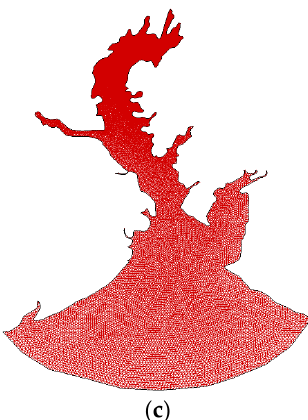
Figure 1. ( a ) Location of Tieshangang Bay; ( b ) Topographic map of Tieshangang Bay; and ( c ) the unstructured grid for the MIKE 21 FM and a close-up of the variable mesh resolution. The performance of MIKE 21 FM was validated against (1) the tide level records at Shatian and Shitoubu, which is obtained from the local tide gauge stations; and (2) the magnitude and direction of velocity records at three temporary measurement points in Tieshangang Bay (Figure 1b). The velocities were obtained from the previous study on this area [15], which were measured in 1-m cell size and 1 Hz data rate with a sampling time of 30 min using Aquadopp Profiler (Nortek Co., Ltd., Bærum, Norway). The results show that the model appears to be in agreement with the tidal level and direction for spring and neap tides (Figures 2–4). However, the magnitude of the velocities might be under- or over-estimated in this model (Figures 2 and 3), partly because of the complex bathymetry and meteorological condition.